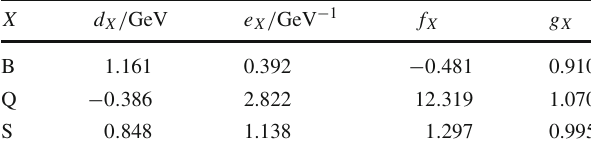
Table 1 Parameter values for the parametrizations of μ fo √ s in Eq. of